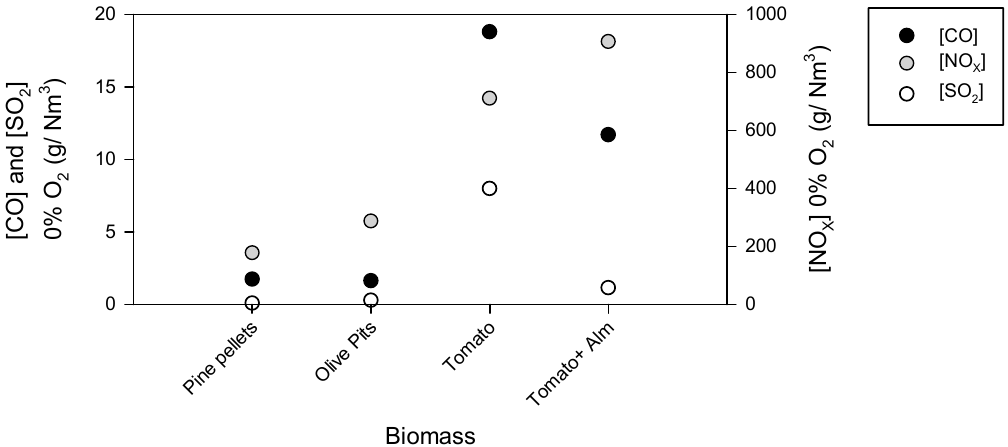
Figure A11. CO, NO X , and SO 2 levels achieved when using the optimal configuration proposed for each biomass stud- ied.